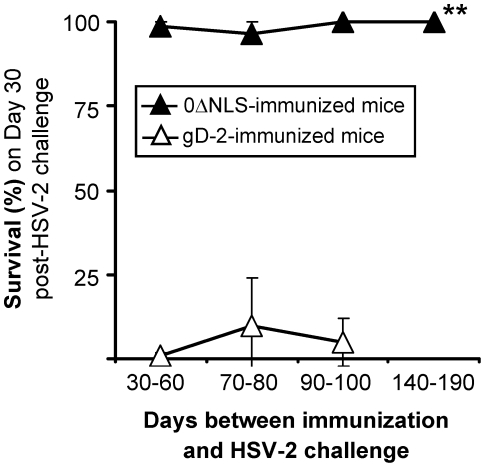
HSV-2 0ΔNLS-induced protective immunity does not decline between Days 30 and 190 post-immunization.The mean ± sem frequency of survival following HSV-2 MS challenge was compared over time in mice immunized with HSV-2 0ΔNLS or gD-2. The gD-2 plot is based on survival frequencies observed in challenge experiments performed between Days 30–60 (n = 1), 70–80 (n = 3), and 90–100 (n = 4) post-immunization. The 0ΔNLS plot is based on survival frequencies observed in challenge experiments performed between Days 30–60 (n = 5), 70–80 (n = 4), 90–100 (n = 4), and 140–190 (n = 2) post-immunization. Specific outcomes of the n = 15 challenge experiments are summarized in Table S1. The double asterisk (**) denotes that differences in percent survival of 0ΔNLS-versus gD-2-immunized mice following HSV-2 MS challenge were significant (p<10−15; two-sided Student's t-test).